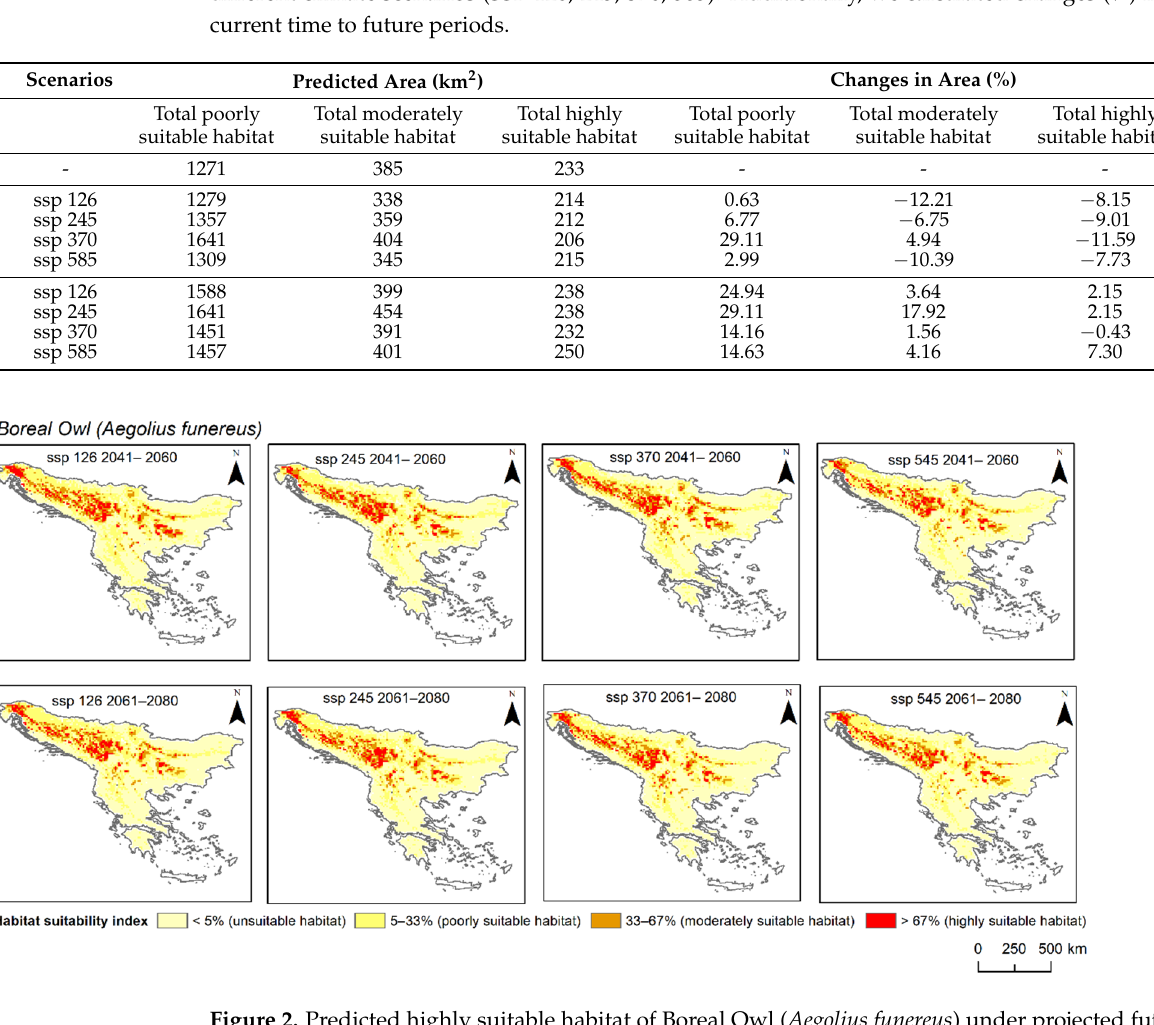
Figure 2. Predicted highly suitable habitat of Boreal Owl ( Aegolius funereus ) under projected future climate scenarios (SSP 126, 245, 370, 585) in two different periods: 2041–2060 and 2061–2080. Colour coding: beige = unsuitable habitat; light yellow = poorly suitable habitat; dark yellow = moderately suitable habitat; red = highly suitable habitat).